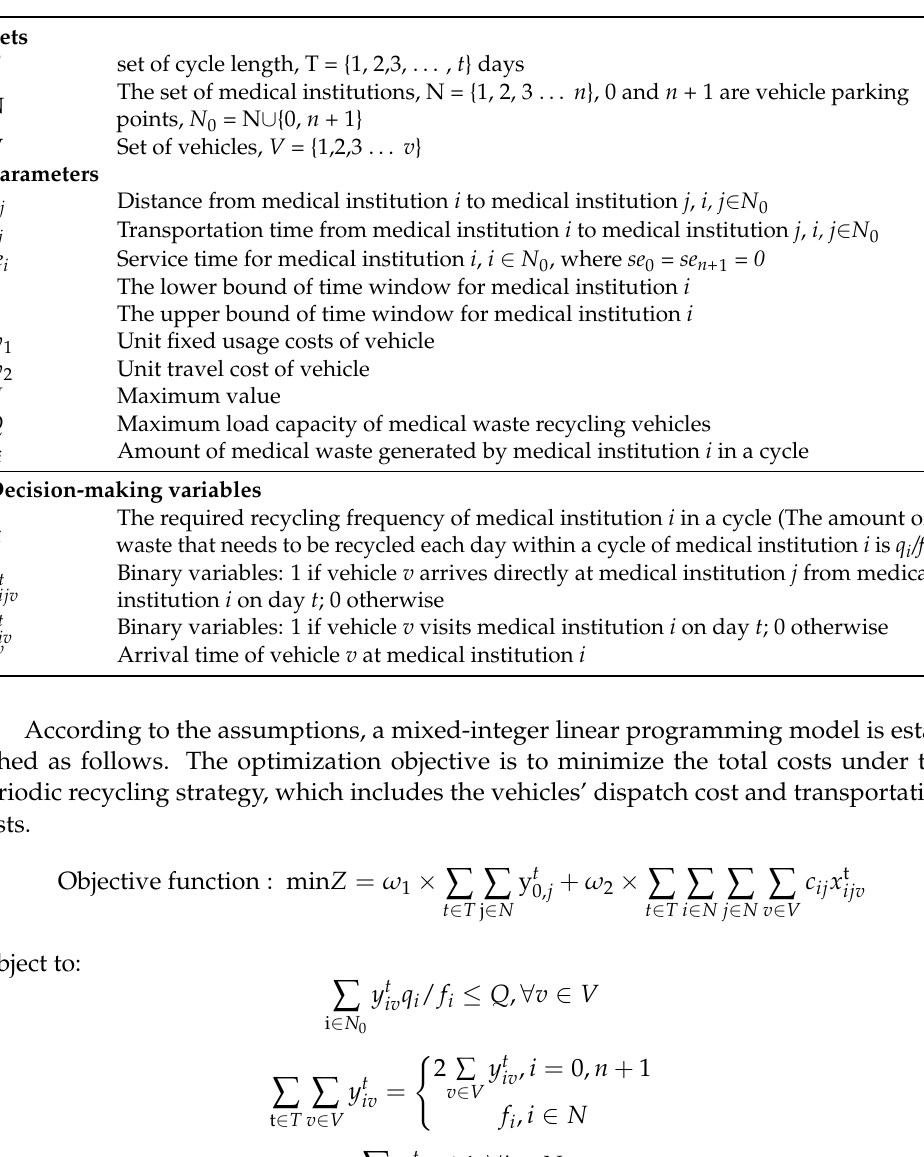
Table 1. Notations of the mathematical